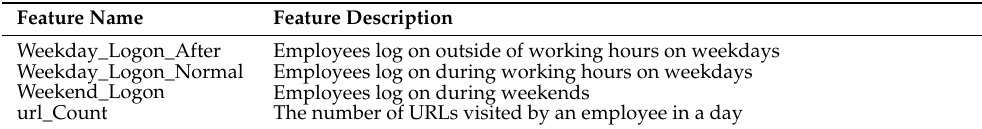
Table 4. Extra features added to enhance the feature extraction